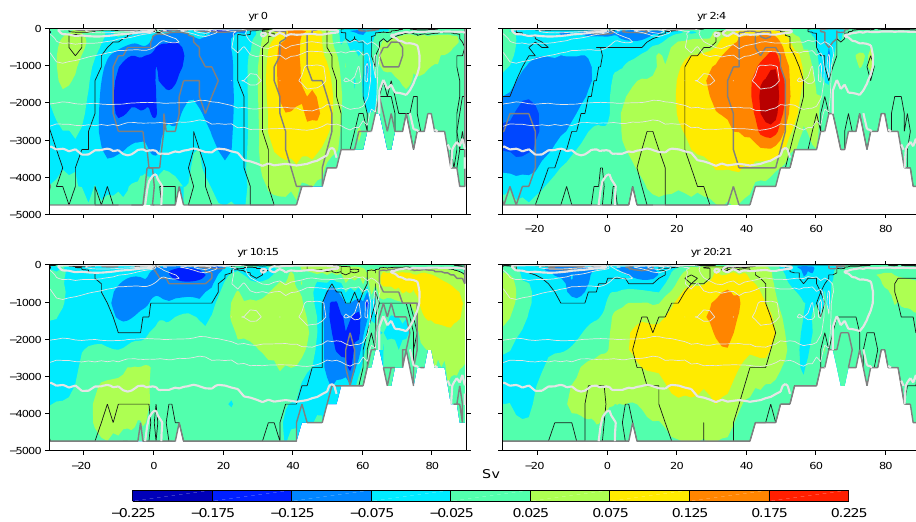
Fig. 11. Composites of anomalous Atlantic meridional streamfunction in phase with the volcanic eruption (left) and following the volcanic eruption (other panels) for the period after 1400 A.D. Positive (negative) values correspond to a clockwise (counter-clockwise) circulation. Black and day grey contours mark significant areas at the 95% and 80% level, respectively, according to the Monte Carlo permutation test. Light grey contours show the annual mean Atlantic meridional circulation in the control simulation (contour interval is 3Sv, thick contour corresponding to the zero